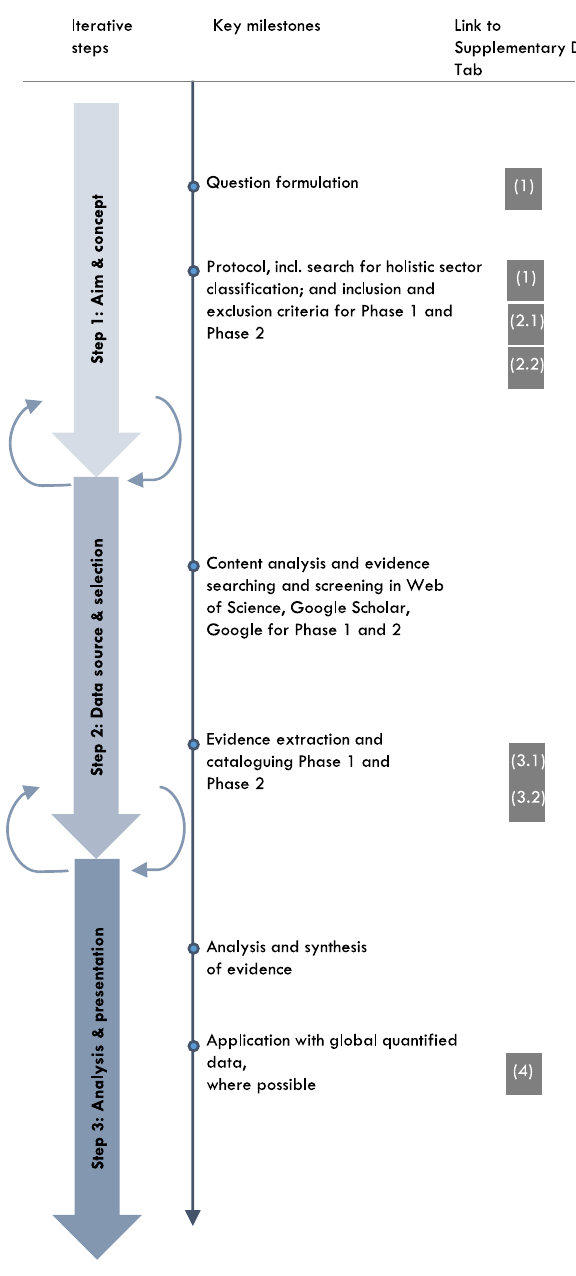
Fig. 7 Overview of the method used to develop and apply our proposed framework for targeting adaptation to safeguard and advance the SDG targets. Left column introduces three main steps of the method, second column shows key milestones within each of the three main steps, third column illustrates the link to the Supplementary Data